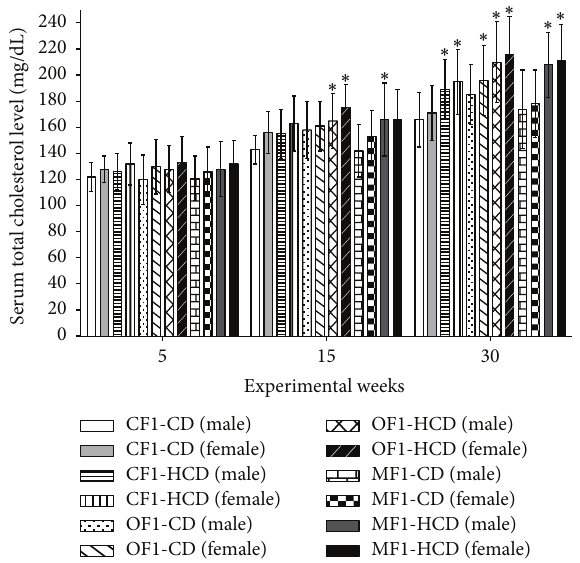
Figure 5: Serum levels of total cholesterol (mg/dL) of all study groups. Data are presented as mean ± SD ( 𝑛 = 10 ). CF1-CD: F1 offspring of control mothers under control diet, CF1-HCD: F1 offspring of control mothers under high-caloric diet, OF1-CD: F1 offspring of obese mothers under control diet, and OF1-HCD: F1 offspring of obese mothers under high-caloric diet; MF1-CD: F1 offspring of malnourished mothers under control diet and MF1- HCD: F1 offspring of malnourished mothers under high-caloric diet. The symbol ∗ indicates significant difference from CF1-CD by ANOVA ( 𝑝 < 0.05 ).